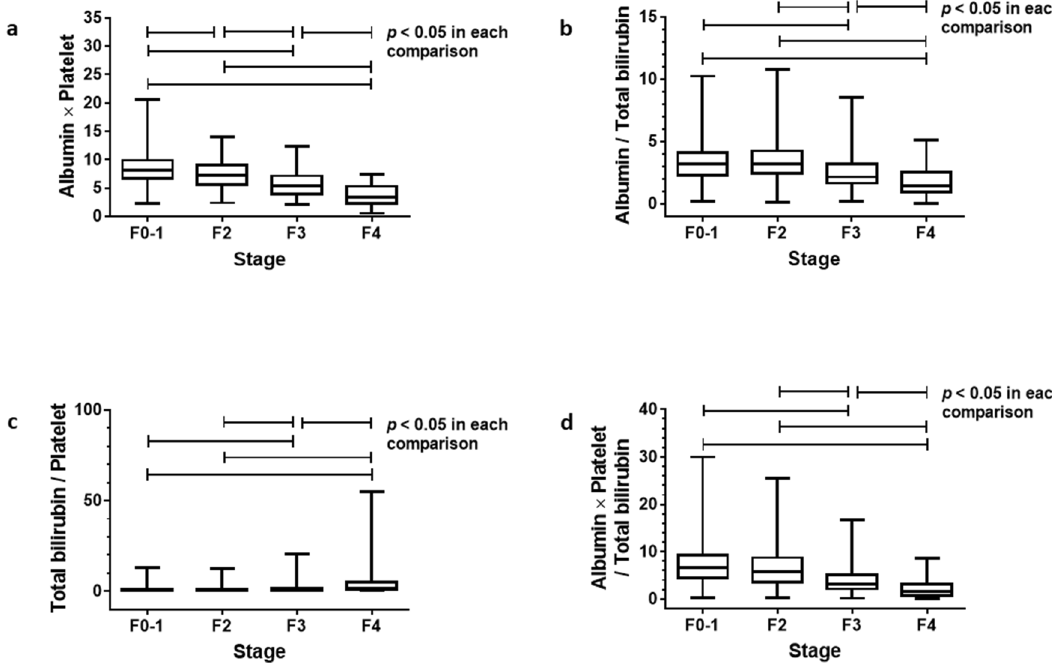
Figure 1. Newly generated fibrosis indices in each fibrosis stage in a training cohort. Median values of Albumin platelet product could differentiate each fibrosis stage ( a ). The other indices, Albumin bilirubin quotient ( b ), Bilirubin platelet quotient ( c ) and Three math; Albumin × platelet/(total bilirubin × 100) ( d ) distinguished stage 4 from stage 3 and stage 3 from stage 2, but failed to differentiate between stage 0–1 and 2 ( p < 0.05). Data were analyzed using the Steel–Dwass